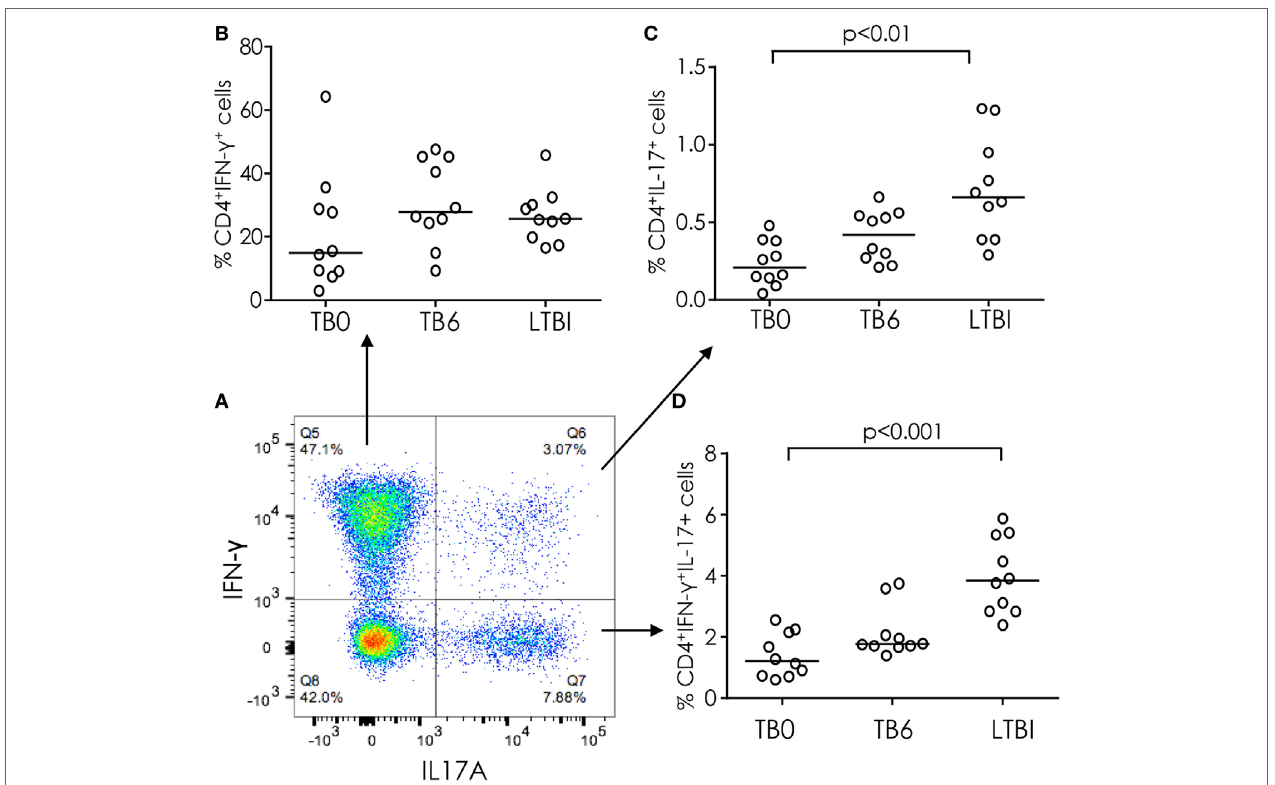
FigUre 2 | IFN- γ and IL-17 production from CD4 + T cells in tuberculosis (TB) infection and disease. (a) Representative FACS plot of IFN- γ and IL-17 production from CD4 + T cells. (B) % CD4 + cells producing IFN- γ alone in TB cases before and after treatment and in latently TB infected (from FACS plot top left quadrant). (c) % CD4 + cells producing both IFN- γ and IL-17 (from FACS plot top right quadrant). (D) % CD4 + cells producing IL-17 only (from FACS plot bottom right quadrant). Data were analyzed using Kruskal–Wallis test with Dunn’s post-test comparison. Bar indicates